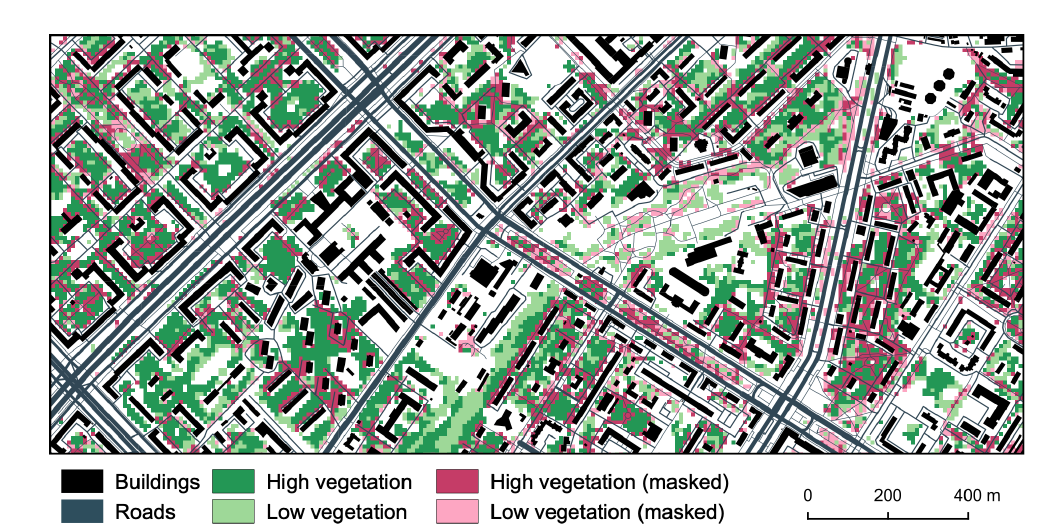
Figure 2. Example of identifying vegetation in the urban environment, and masking vegetation pixels that intersect with buildings and roads from Samsonov et al. [68]. Masked pixels are considered as vegetated when defining impervious area fraction (ISA) in REF1 dataset and as paved in REF2